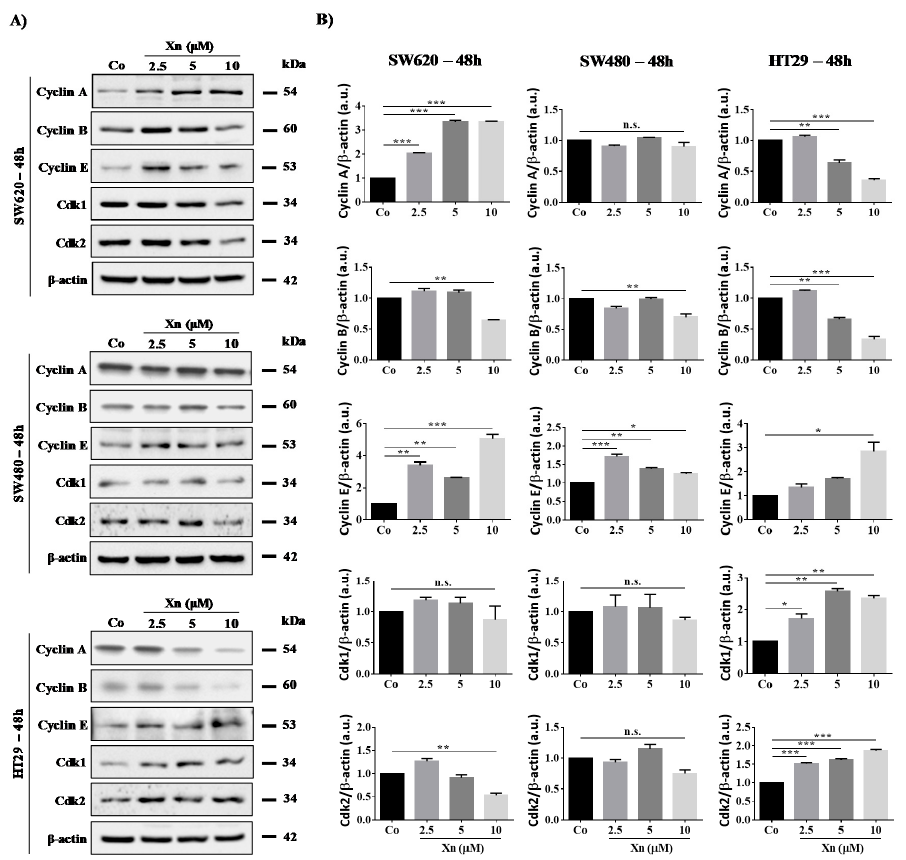
Figure 4. Modulation of key cell cycle regulators after 48 h of treatment with xanthohumol (Xn) in colon cancer cell lines. ( A ) Immunoblot analysis of Cyclin A, B, E, Cdk1, and Cdk2 in Xn (2.5, 5, and 10 µM)-treated SW620, SW480, and HT29 cells for 48 h. β -actin: loading control. ( B ) Densitometry